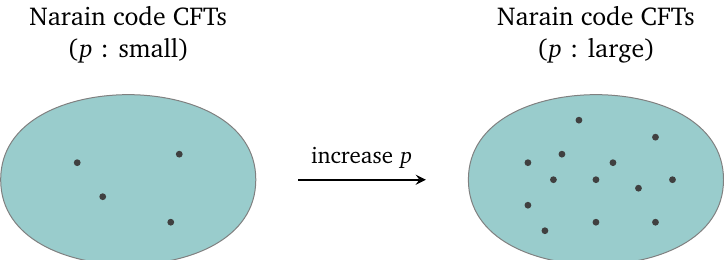
Figure 2: The discrete subset of Narain code CFTs constructed from the CSS codes (the black dots) in the whole Narain moduli space (the green region), which depends on a prime number p . For small p , the corresponding Narain code CFTs make a relatively small subset (black dots on the left). On the other hand, for large p , the number of the Narain code CFTs grows (black dots on the right) and we expect that the averaged theory over the ensemble resembles the one over the whole Narain